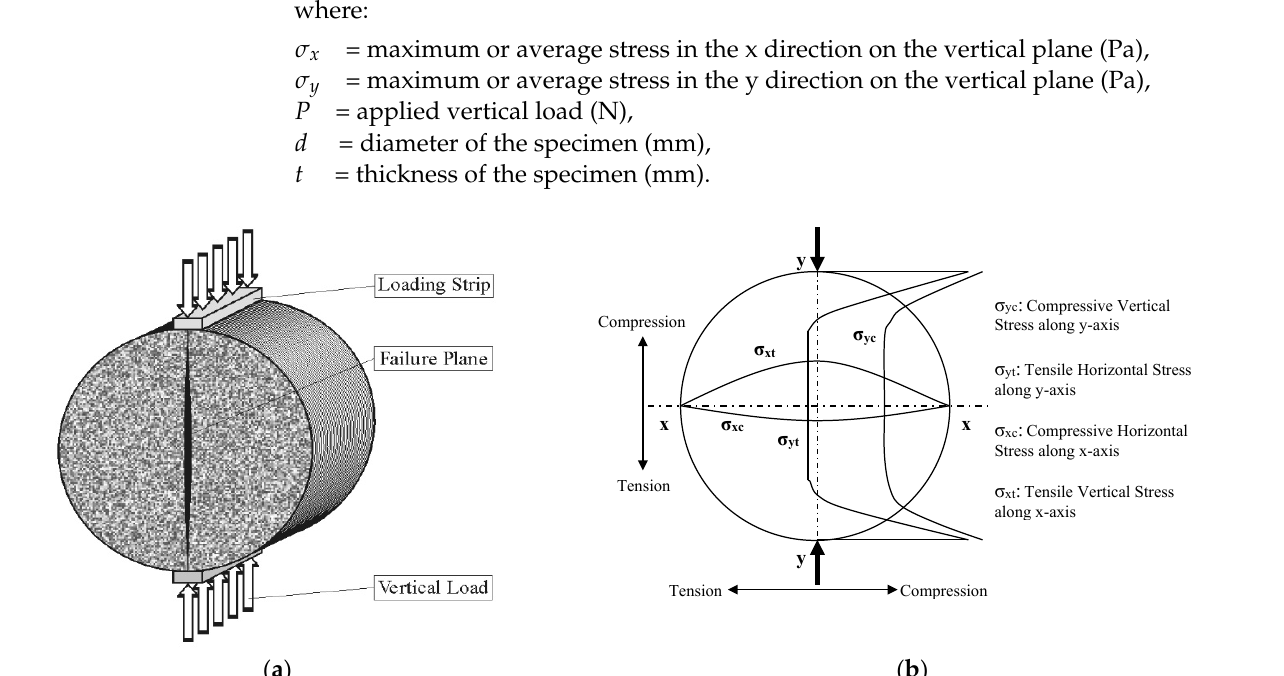
Figure 4. Schematic illustration of Indirect Tensile Strength (ITS) test: ( a ) Indirect tensile loading, ( b ) Stress distribution in an indirect tensile test specimen.